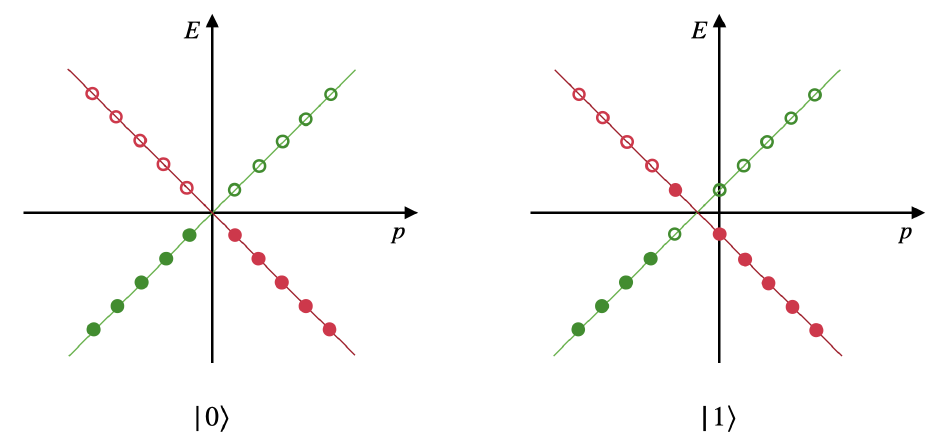
Figure 6. Effect on the energy spectrum because of the presence of a non-zero gauge potential. We see that a left-handed particle (red) is created while a right-handed particle (green) is